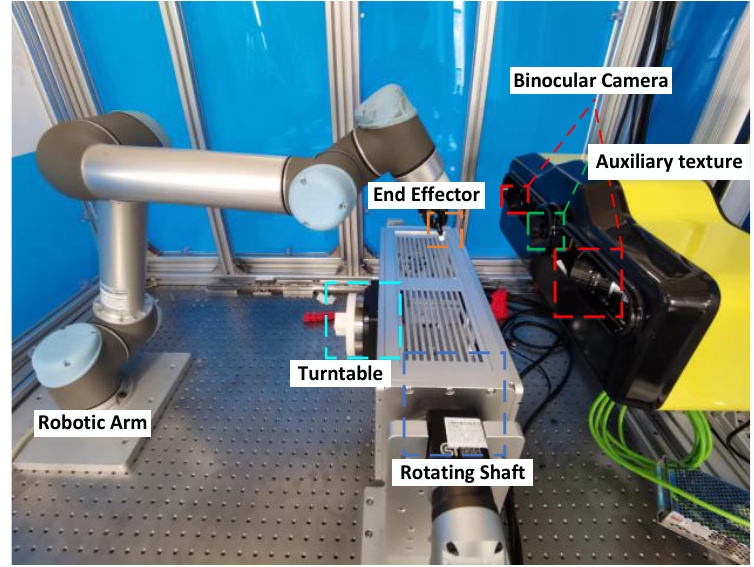
Figure 3. The structure of the workspace. The vision system mainly included two symmetrically arranged high-resolution cameras and an auxiliary texture device in the middle. The workpiece was placed in the white slot on the turntable. The turntable and rotating shaft could change the pose of the object. Tools could be clamped by the end effector and be moved by the robotic arm.